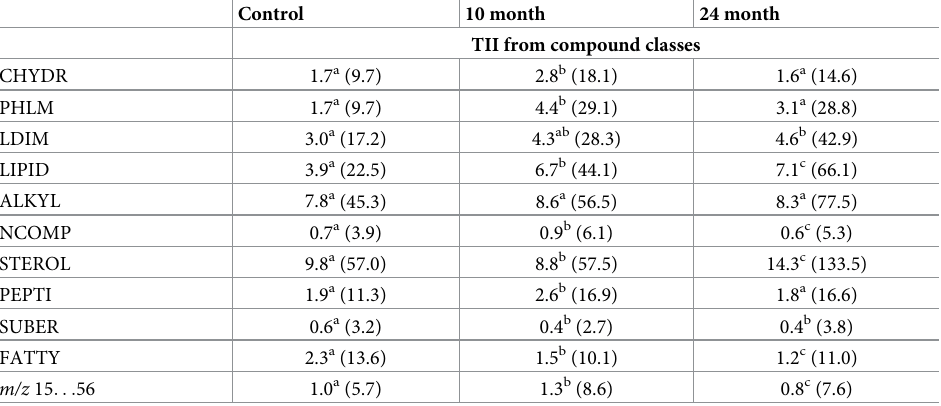
Table 3. Proportions of ion intensity of different compound classes (%TII) and total ion intensity in parentheses (TII counts mg -1 ) of the microaggregate size fraction of topsoil samples of the control without clear-cut, 10, and 24 month after clear-cut. Values followed by the same letters within a compound class were not significantly different (P < 0.05, n =